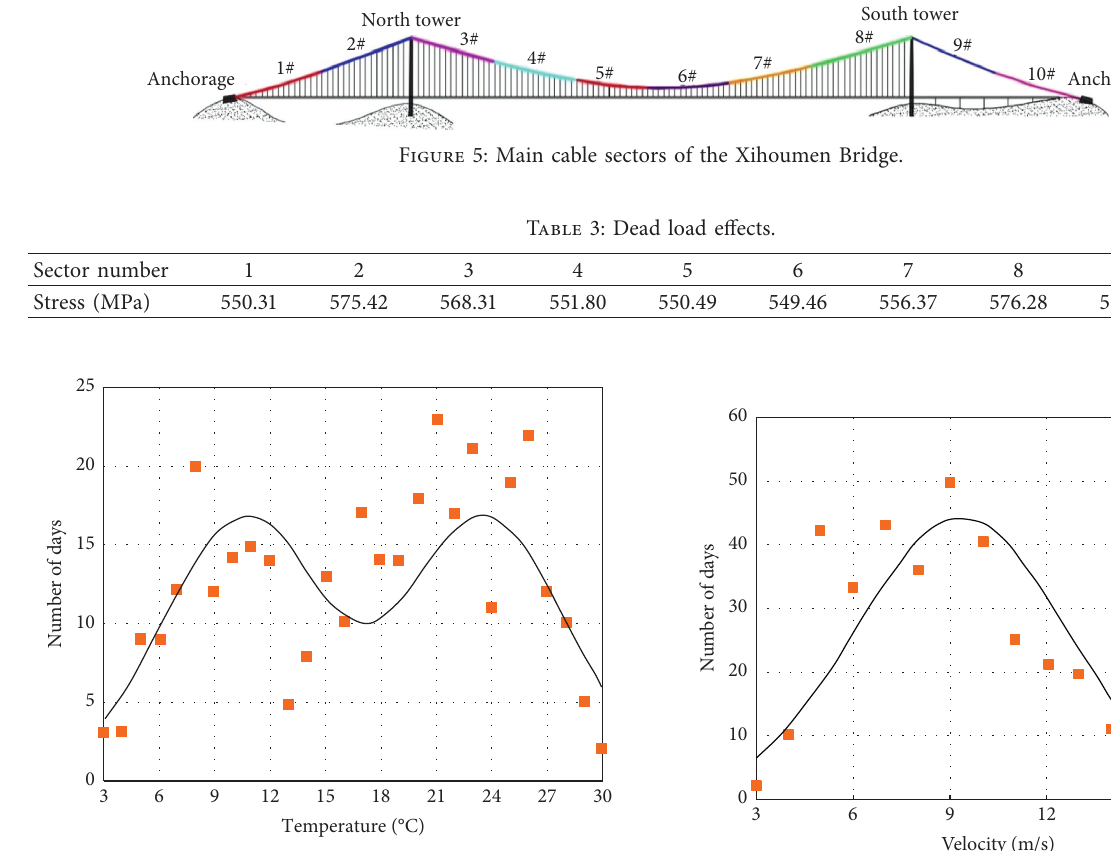
Figure 8: The frequency distribution of wind velocity.